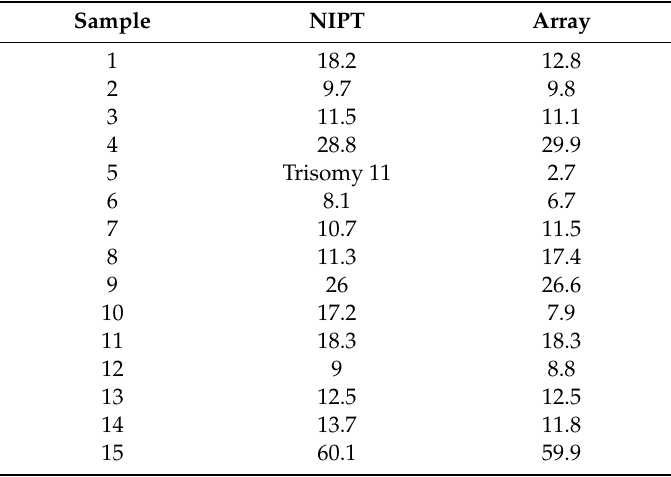
Table 2. Correlation of CNV sizes (Mb) between array and NIPT.